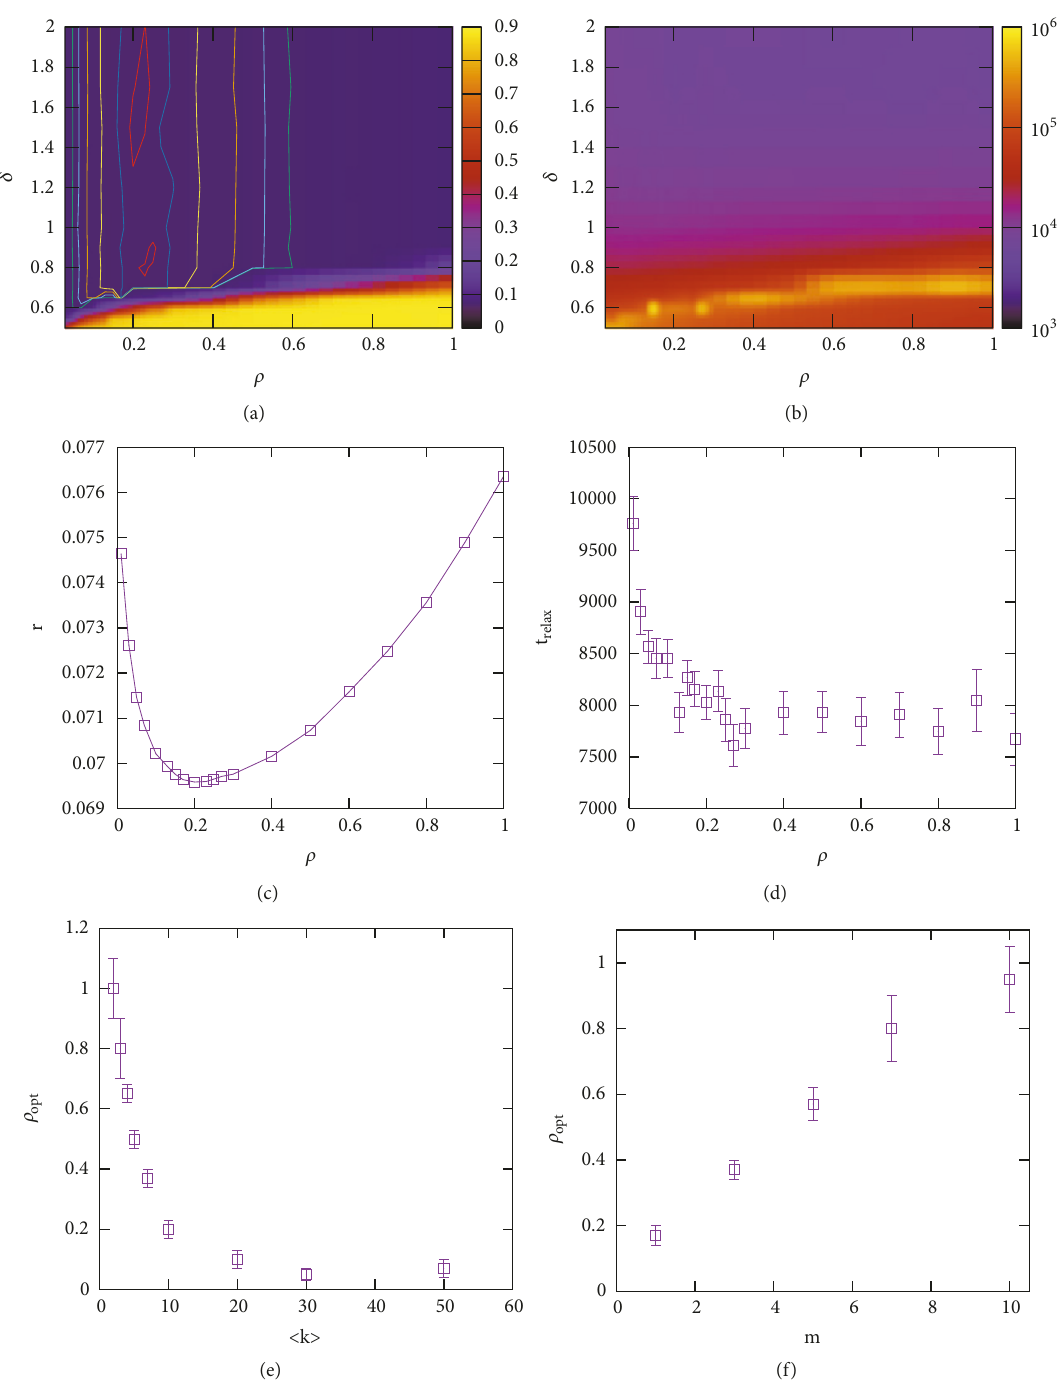
Figure 5: Dependence of (a) the stationary spread 푟 and (b) the convergence times 푡 relax on the tolerance parameter 훿 and the density of influence optimizing agents 휌 . For (a) isolines at 푟 = 0.0696,0.0697,0.0700,0.0705,0.0710,0.0715 have been added to visualize the optimum at 휌 ≈ 0.2 . (c) and (d) show the dependence of 푟 and 푡 relax on 휌 for 훿 = 1.5 . Panels ((e), (f)) show the dependence of the optimal proportion of influence-maximizing agents on (e) the average connectivity of the social network ⟨푘⟩ and on (f) the intensity of influence maximization 푚 . Results are averaged over 50 independent runs for a system of 푁 = 1000 nodes, noise Δ = 0.001 , ⟨푘⟩ = 10 , and 푚 = 1